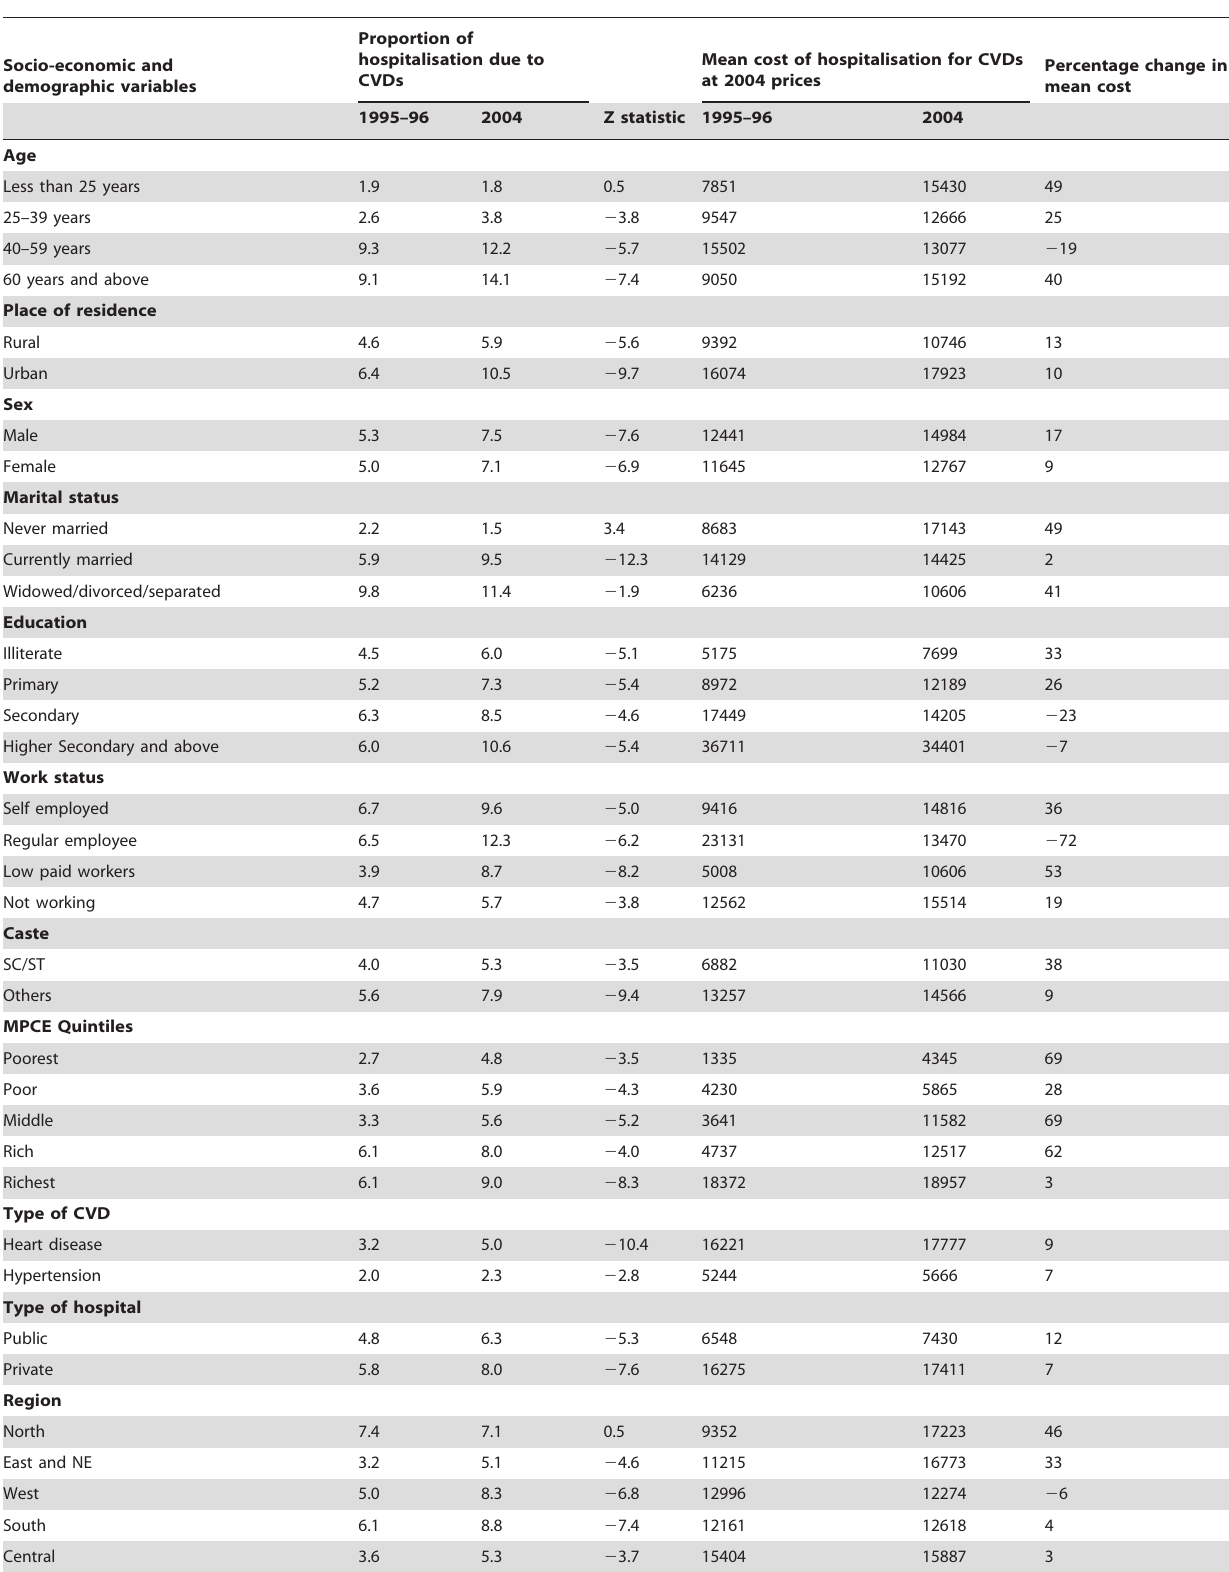
Table 3. Socio-economic differentials in hospitalisation and mean cost of hospitalisation for cardiovascular diseases, India, 1995–